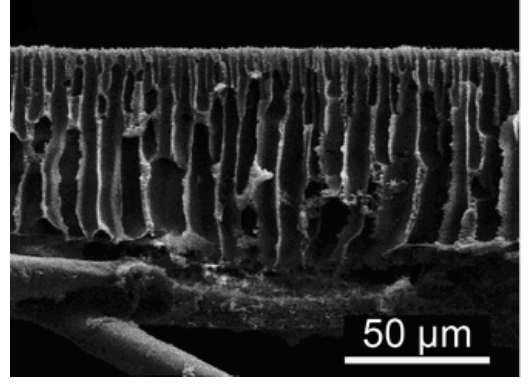
Figure 9. SEM micrograph of the cross section of a PSf TFC membrane